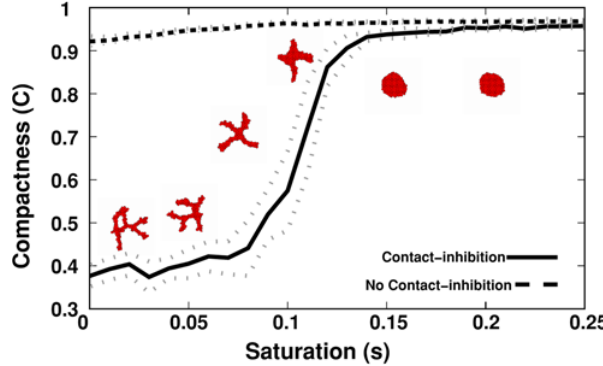
Figure 9. Compactness ( C = A cluster / A hull ) of 128-cell clusters on 200 6 200-lattices ( , 400 m m 6 400 m m) after 5000 MCS ( , 40 h) for standard chemotaxis as a function of the saturation of the chemotactic response, s . Insets: representative configurations after 5000 MCS ( , 40 h).